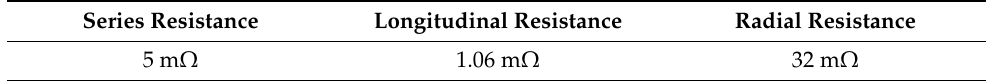
Table 6. Resistance calculation results.